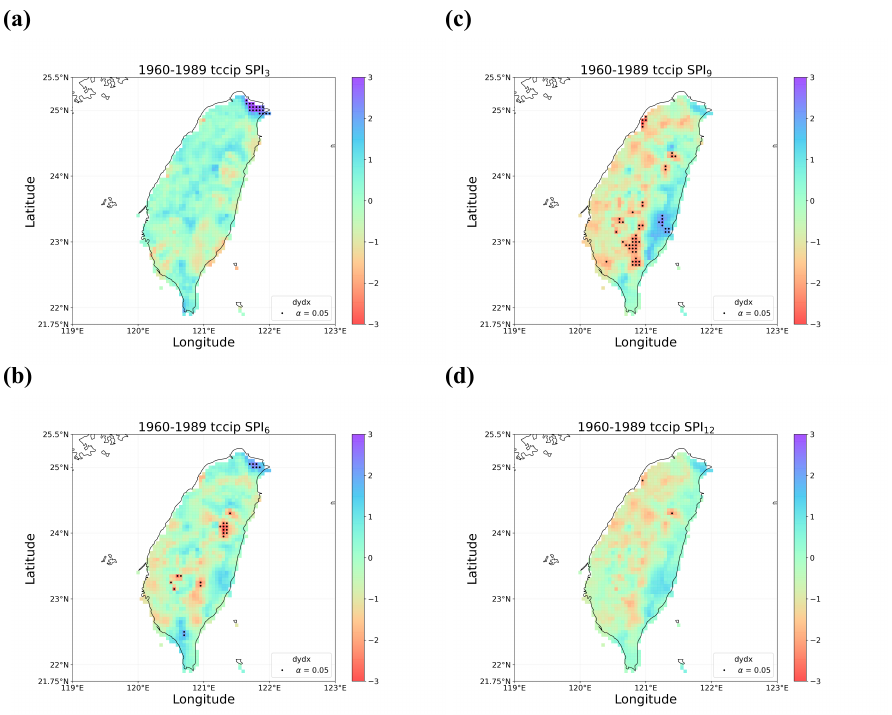
Figure 8. The same as Figure 7, but for detected trends using first derivatives of RMTB.